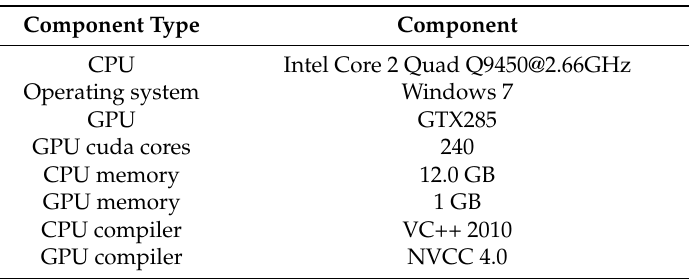
Table 2. Test hardware